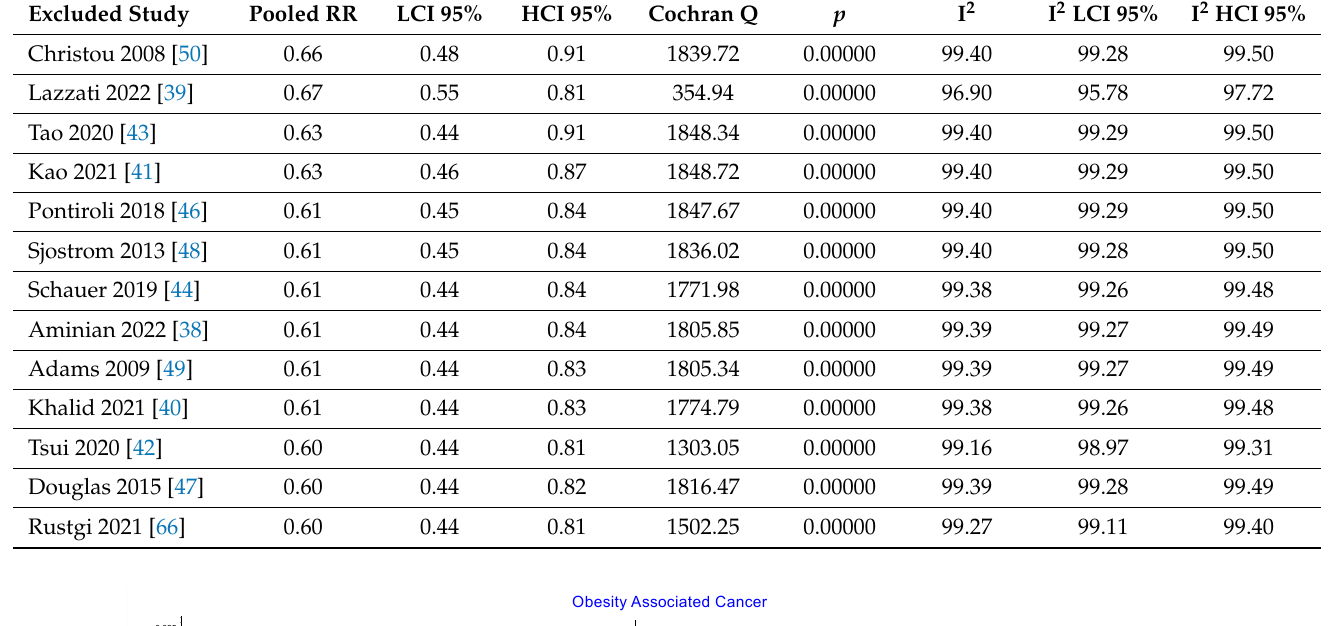
Obesity Associated Cancer